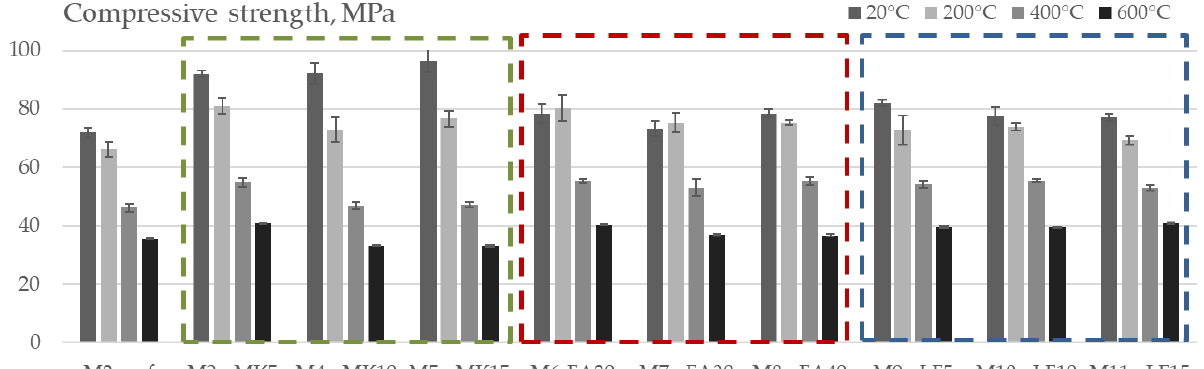
Figure 9. Compressive strength vs. temperature of tested mixes.